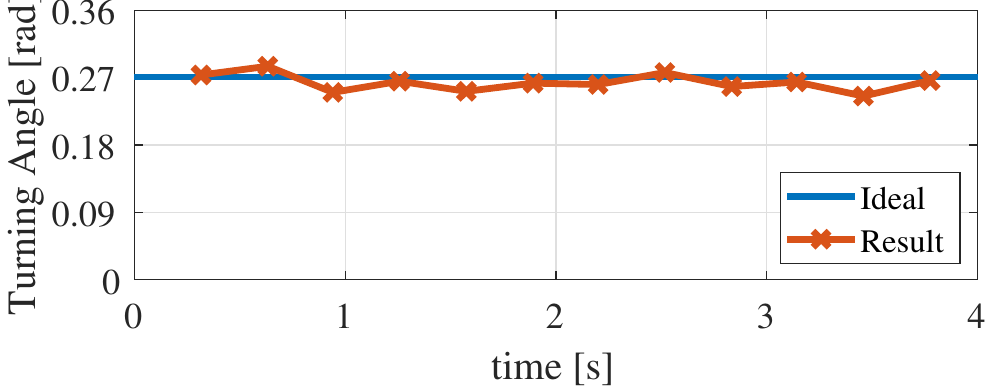
Figure 27. The time variation of the turning angle in the 10th counter-clockwise turning locomotion